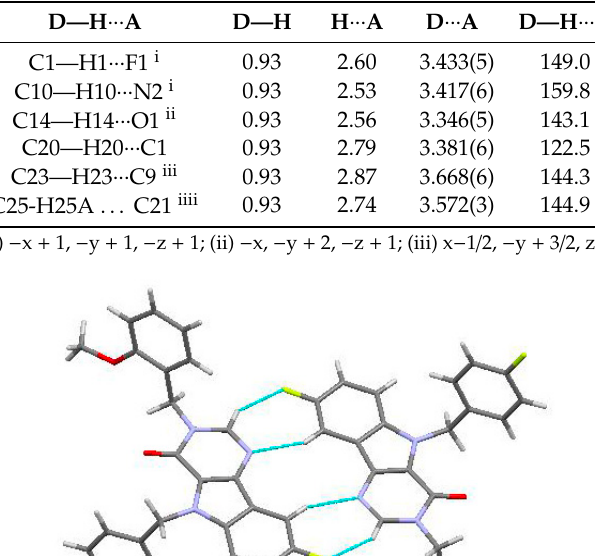
Figure 2. The molecular structure of the title Compound ( 3 ), showing the atom labeling. Displacement ellipsoids are drawn at the 50% probability level. Table 1. Hydrogen bond characteristics (Å, ◦ ) in the crystal of Compound ( 3 ).